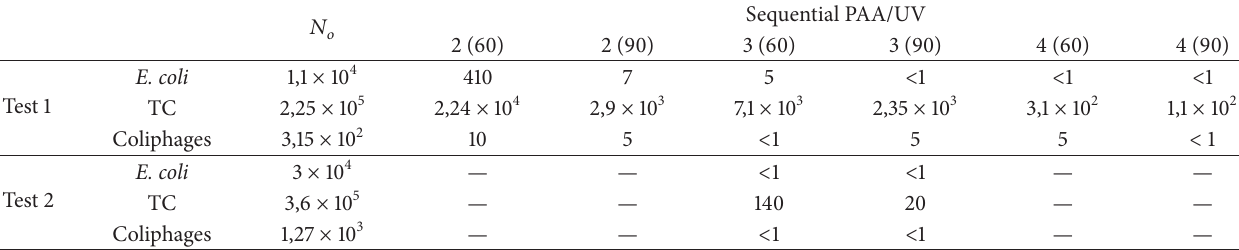
Table 2: E. coli, TC, and coliphages inactivation, employing the PAA/UV sequential method in tests with